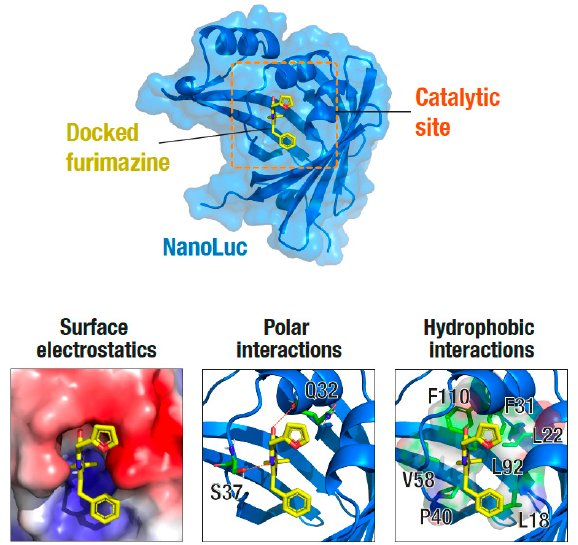
Figure 3. NanoLuc catalytic site structural analysis. Top panel: Surface and cartoon representation of the NanoLuc structure (PDB: 5IBO) showing the docked furimazine substrate at the catalytic site. The substrate, furimazine, was docked using the Autodock Vina software. Bottom panels: zoomed-in view of the catalytic site showing surface electrostatics (left), polar interactions (middle) and hydrophobic interactions (right) formed by furimazine.